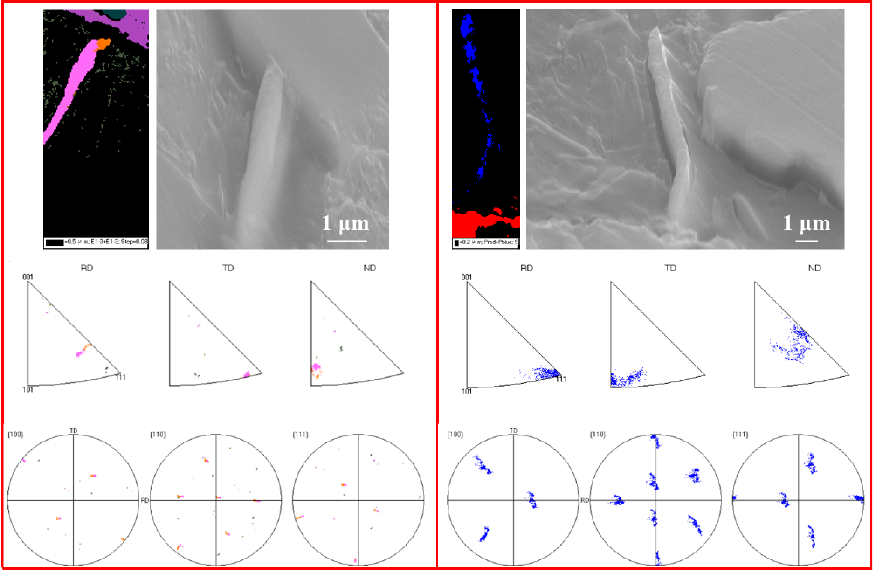
Figure 11. The EBSD results in the longitudinal section of iron whiskers.